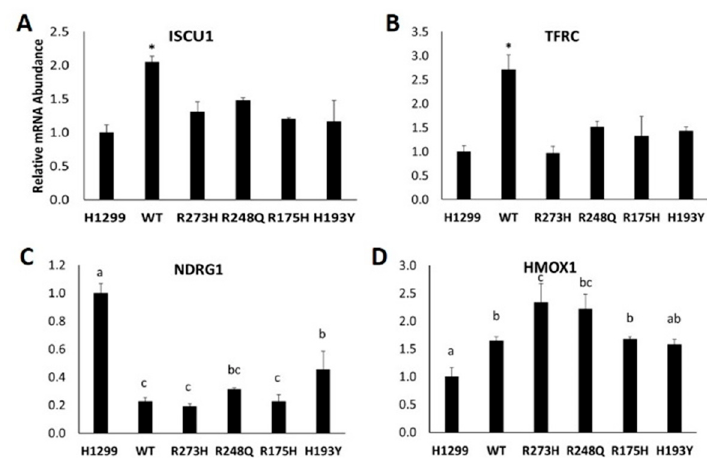
Figure 2. Effect of mutant TP53 expression on iron-related gene expression. Relative mRNA expression of ( A ) iron–sulfur cluster assembly enzyme 1 (ISCU1), ( B ) transferrin receptor 1 (TFRC), ( C ) N-MYC downstream regulated gene 1 (NDRG1), and ( D ) heme oxygenase 1 (HMOX1) in TP53 null H1299 cells (H1299) or H1299 cells transfected with wild-type (WT) TP53, or the indicated mutant TP53. * Denotes statistical difference from H1299. Superscripts (a,b,c) denote statistical significance between mutation types, p < 0.05. Treatments that share the same superscripts are not significantly different.